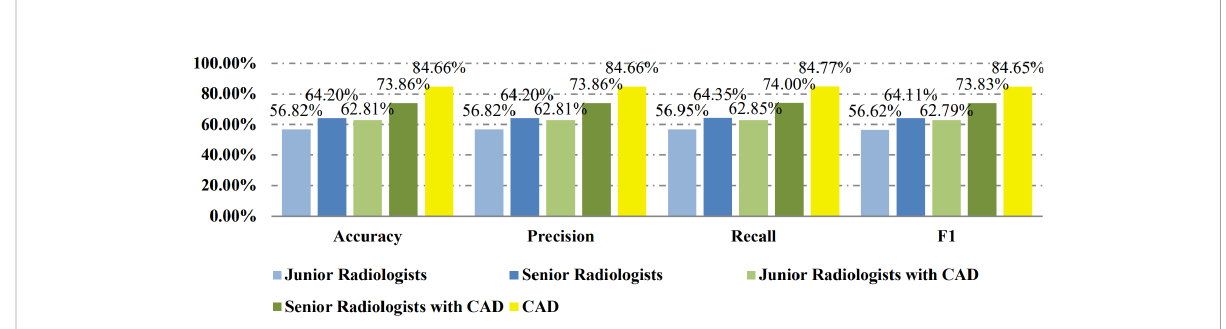
FIGURE 4 Evaluation results for CAD and different radiologists on the balanced data